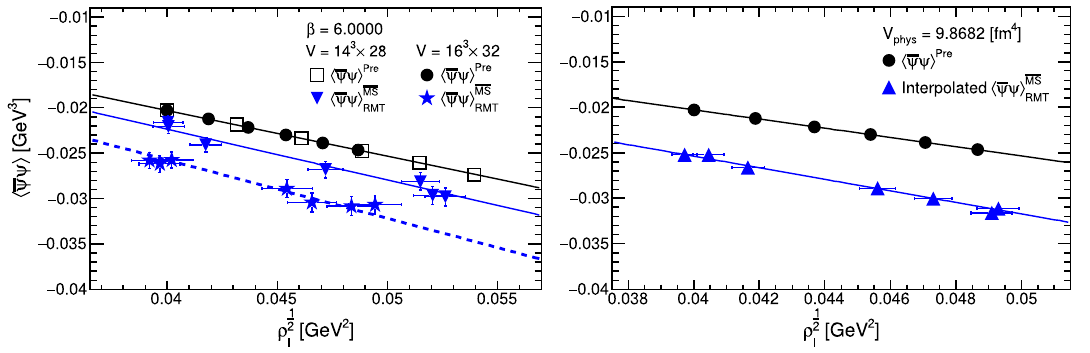
lines indicate the fitting results of the predictions, the numerical RMT results of V = 14 3 × 28, and V = 16 3 × 32, respectively. In the right figure, the black full line and the blue full line indi- cate the fitting results of the prediction and the interpolated results, respectively